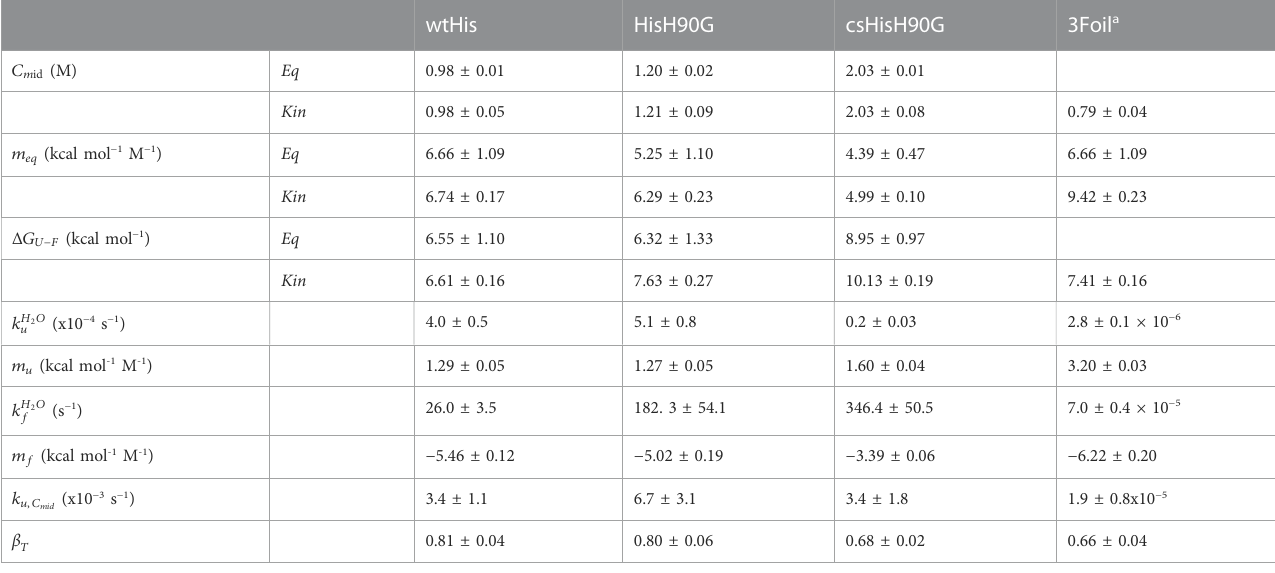
TABLE 2 Equilibrium and kinetic parameters for wtHis, HisH90G, csHisH90G, and